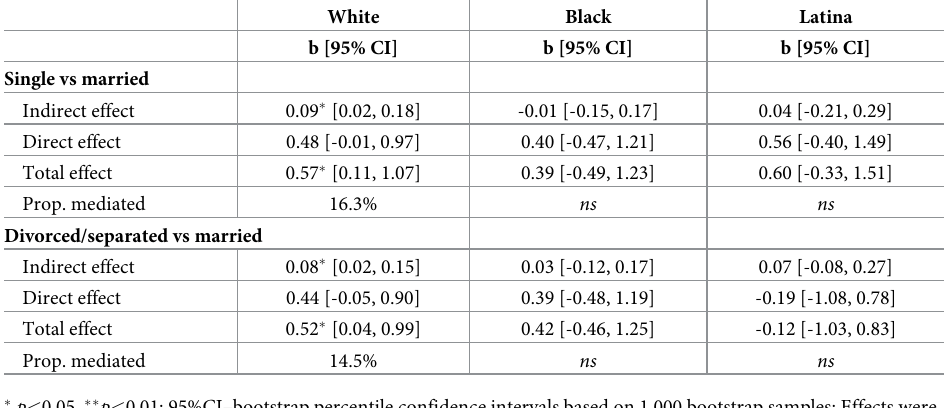
Table 2. Mediation analysis predicting legal abortion support via gender linked fate.